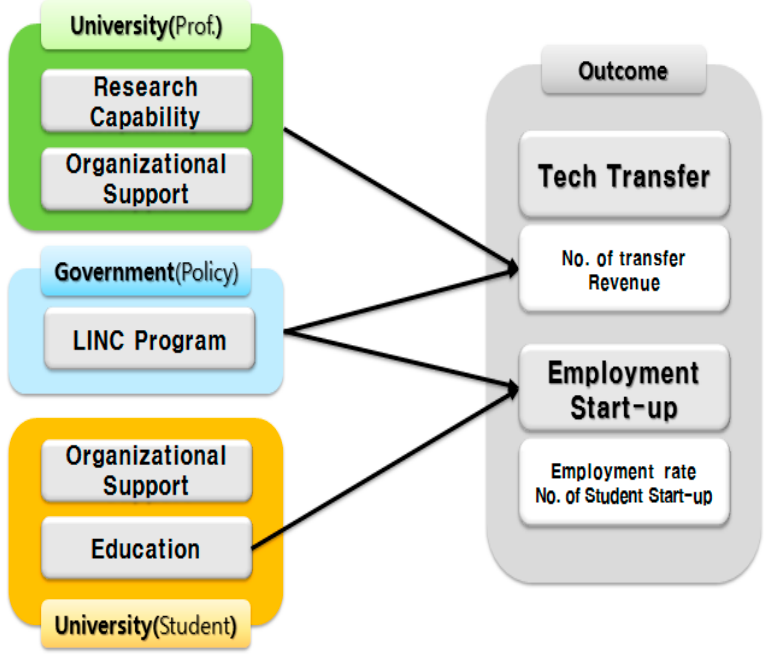
Figure 2. Research Figure 2. Research Model.